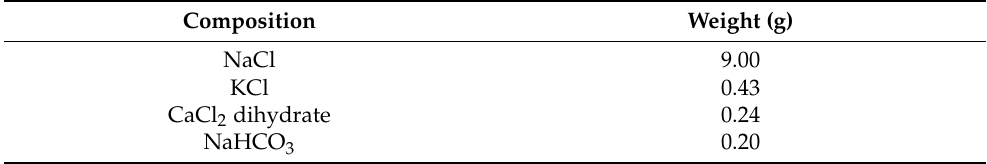
Table 2. Composition of the Ringer’s solution (g/L).